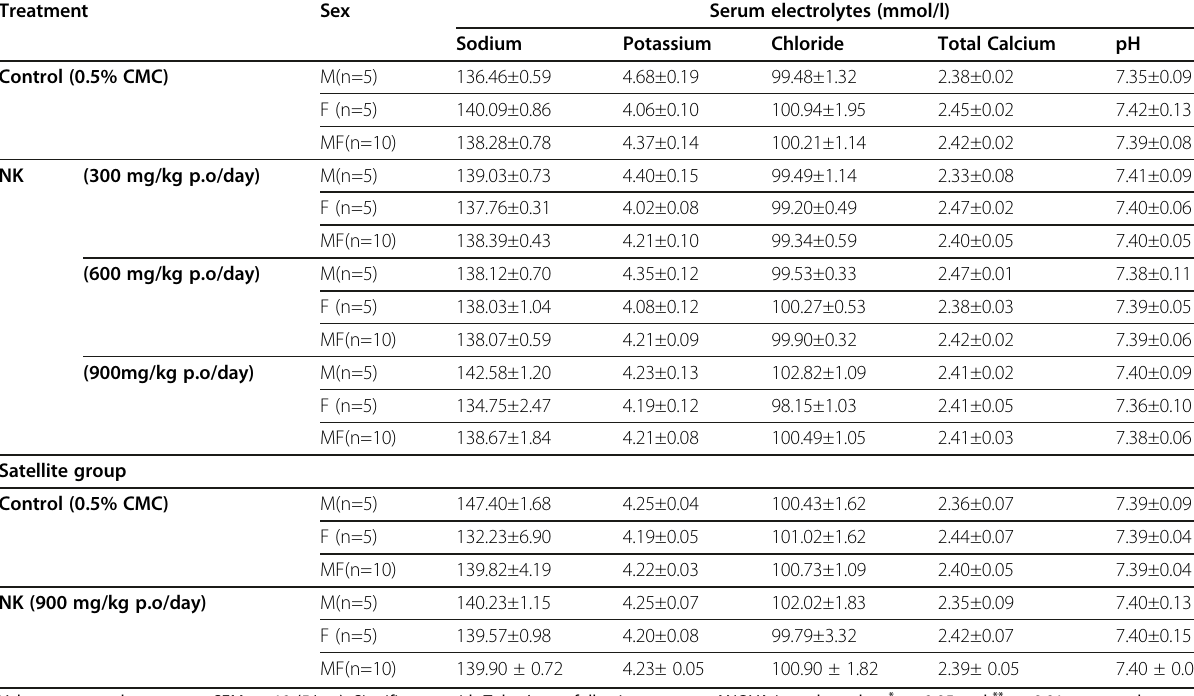
Table 9 Effect of Nuna kadugu on serum electrolytes of experimental Sprague Dawley rats in repeated oral toxicity study Treatment Sex Serum electrolytes (mmol/l) Sodium Potassium Chloride Total Calcium pH Control (0.5% CMC)